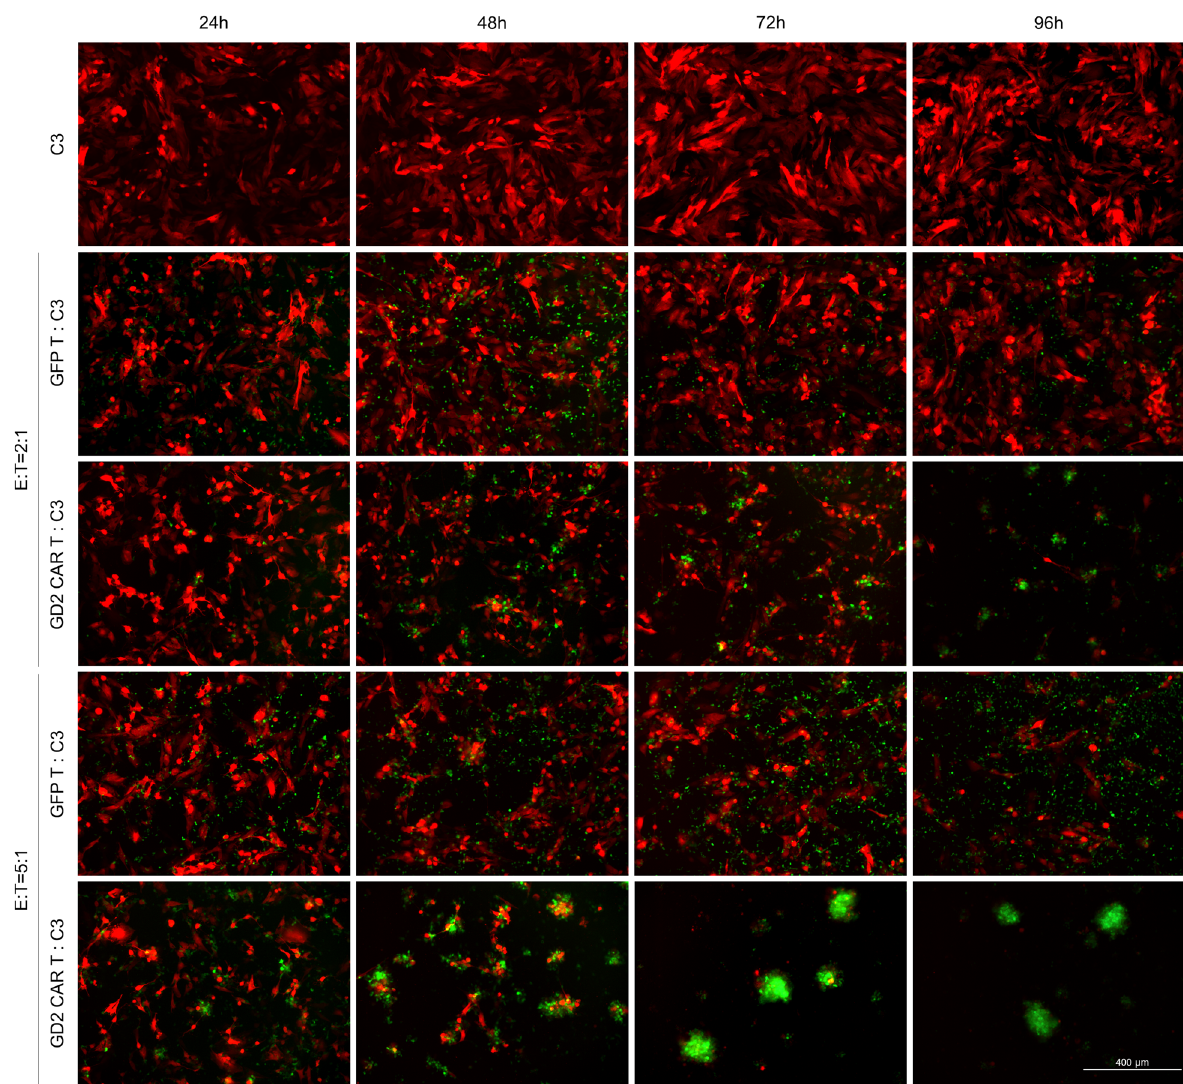
Fig. 3 GD2 CAR T cells generate clusters to eradicate patient-derived primary glioblastoma cells. Representative fl uorescence micrographs highlight a robust cluster activation and killing activity of GD2 CAR T population against primary glioblastoma cells. This feature was never evident in GFP T control cells. DsRED C3 glioblastoma (red) cells in co-culture with GD2 CAR T (green) and GFP T control cells (green) at 2:1 and 5:1 E:T ratios at 24, 48, 72, and 96 h. The scale bar: 400